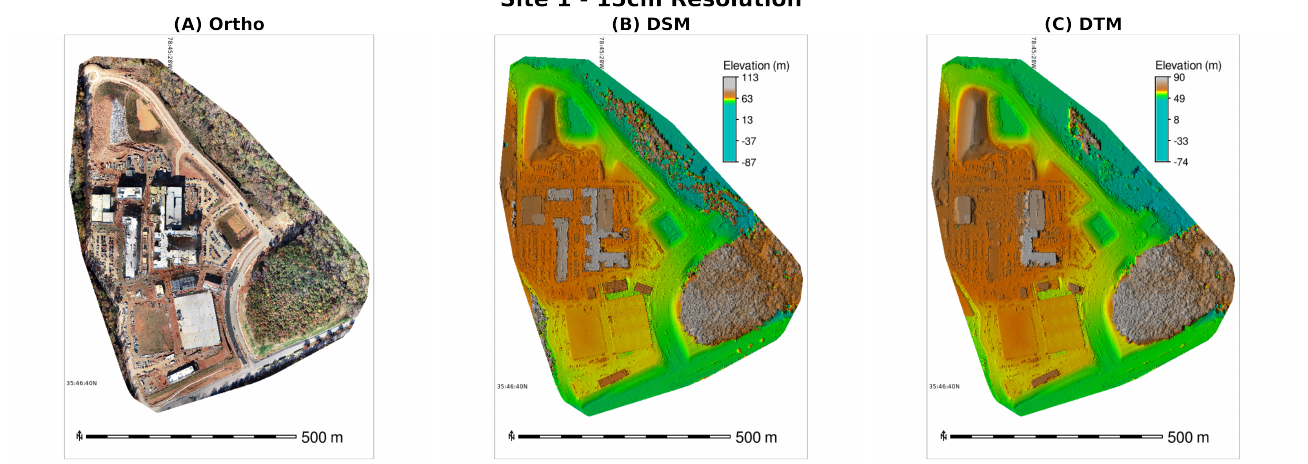
Figure 10. WebODM processed data generated from the UAS flight: ( A ) orthomosaic, ( B ) DSM, ( C ) DTM at 15 cm